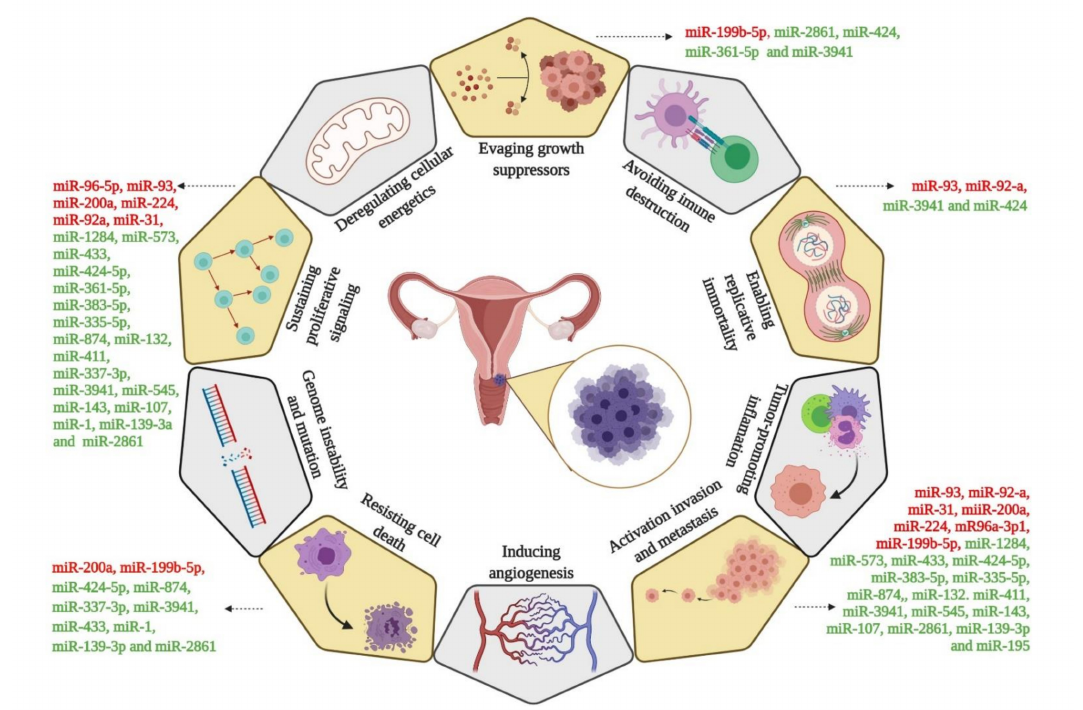
Figure 4. Different miRNAs affecting the hallmarks of cervical